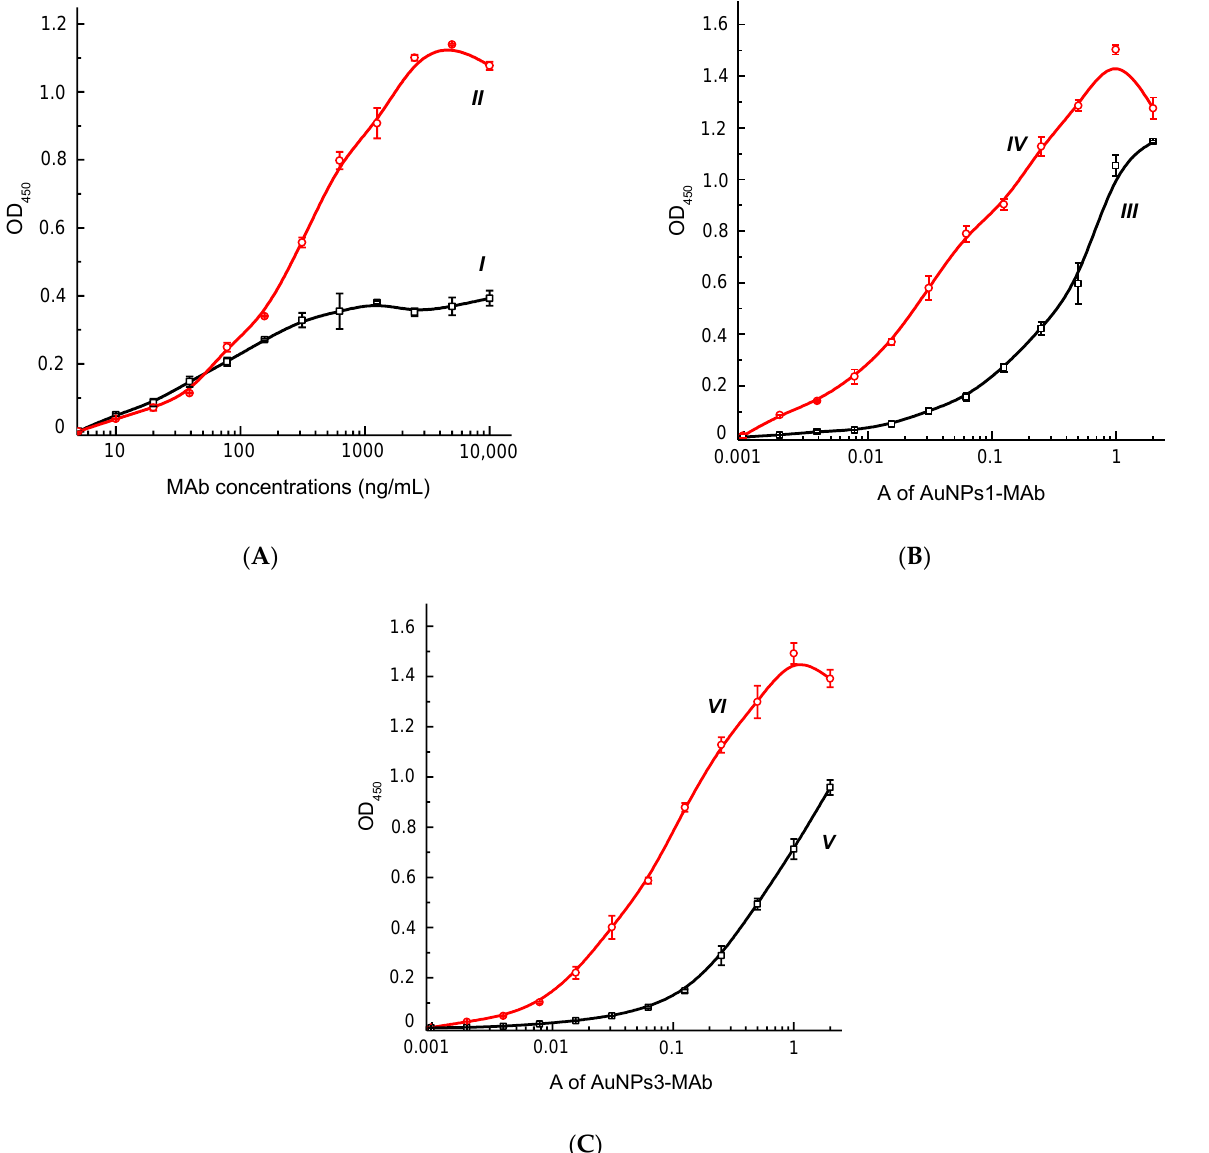
Figure 2. Dependences of OD 450 on the concentration of MAbs ( A ) of clones Fb11 (I) and T143 (II) and the OD of AuNPs1 – Fb11 (( B ), III), AuNPs1 – T143 (( B ), IV), AuNPs3 – Fb11 (( C ), V), and AuNPs3 – T143 (( C ), VI) conjugates. F. tularensis LPS was immobilized in the microplate wells at the concentration of 3 µg/mL. All measurements were performed in triplicate.